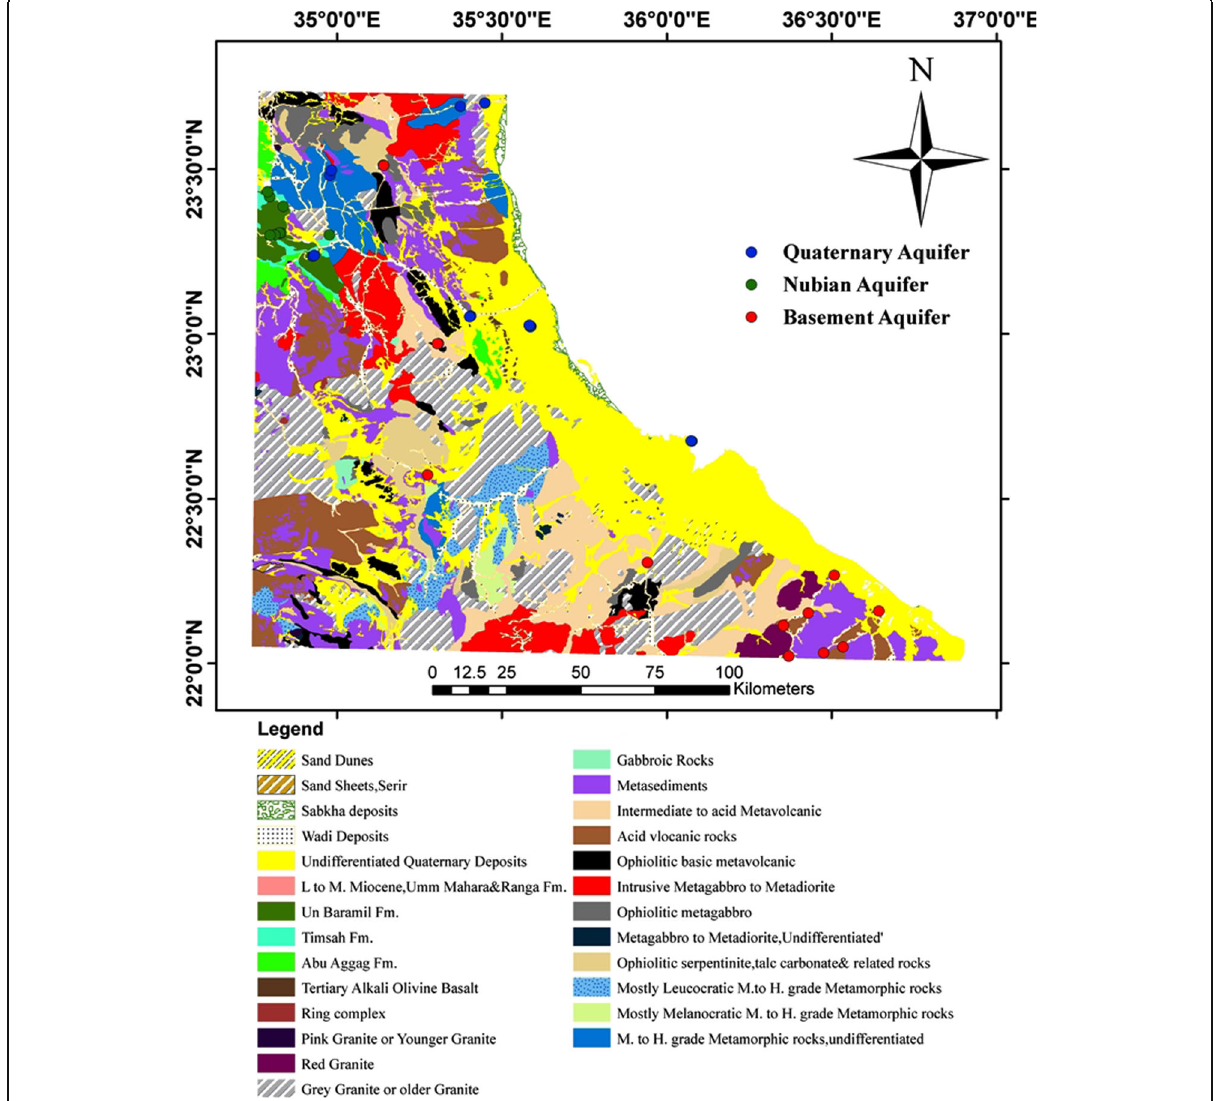
Fig. 3 Geologic map of the study area, Conoco map (1987), showing the locations of the wells from the three studied